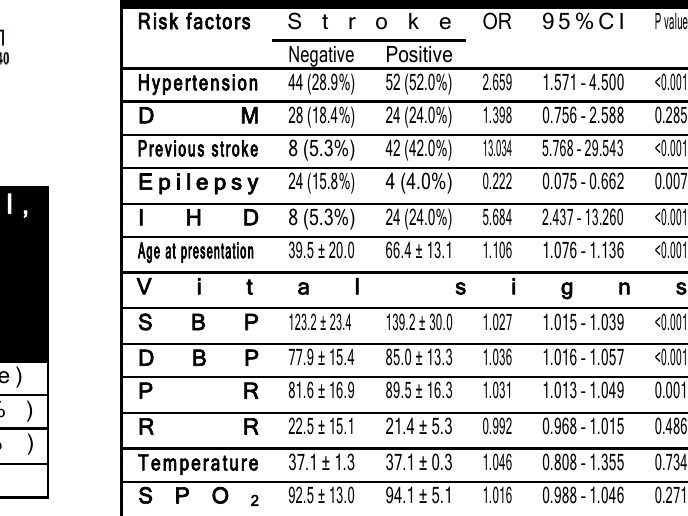
Figure 2: percentage of co morbid disease admitted in medical ward Table 4: risk factors that correlated with